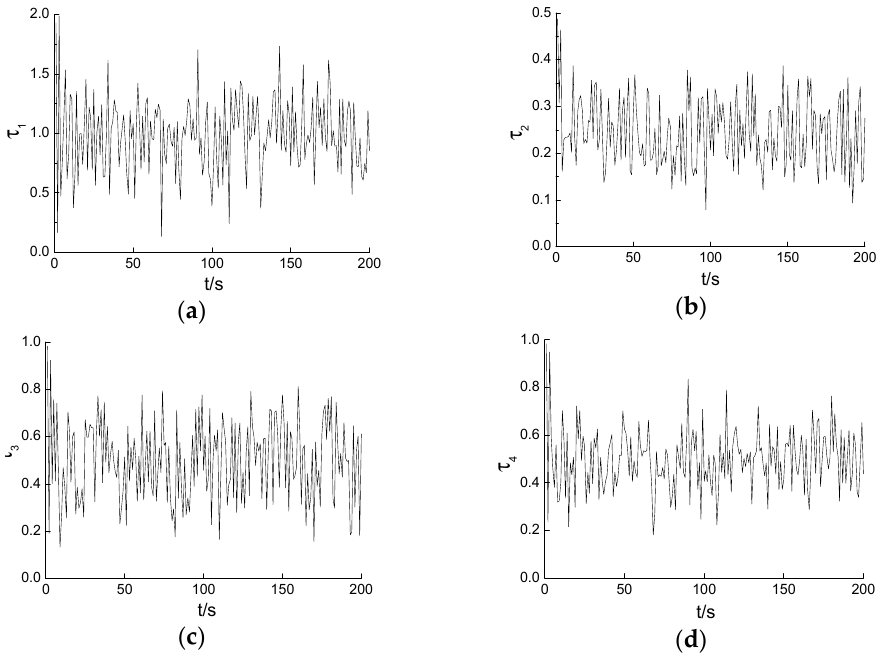
12 of 17 Table 4. Specifications of the optimal structure for Wiener models. Model Type